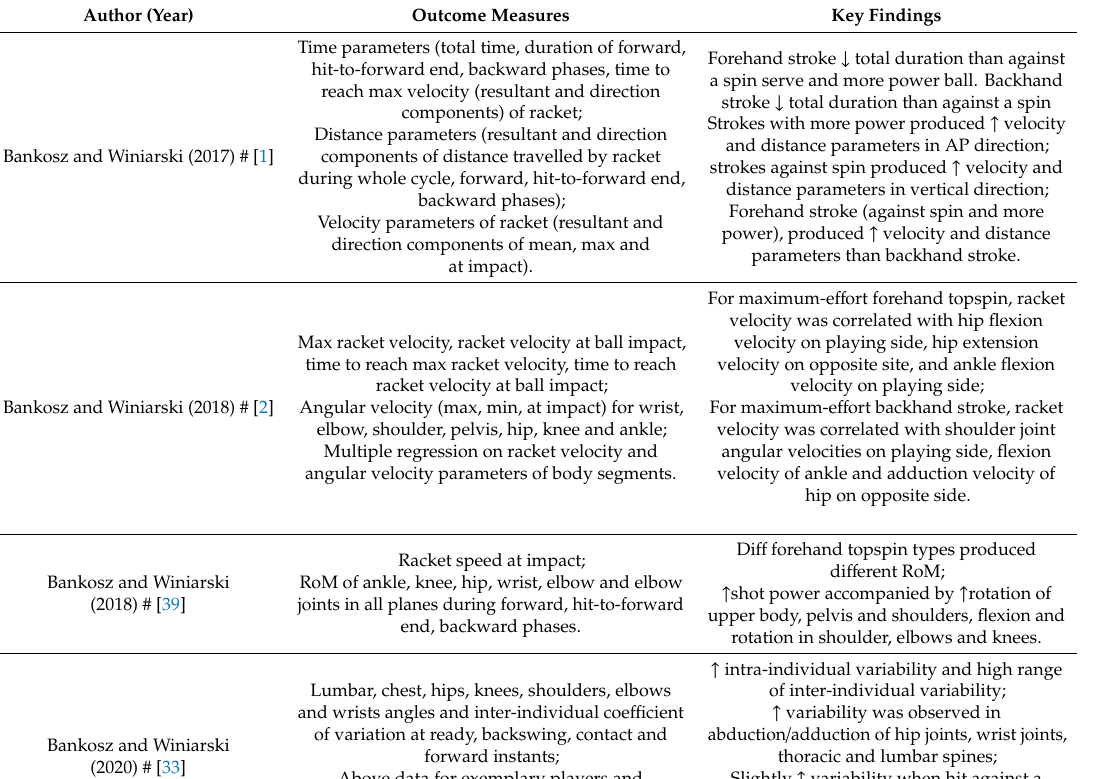
Table 4. Key findings of included studies comparing di ff erent movement